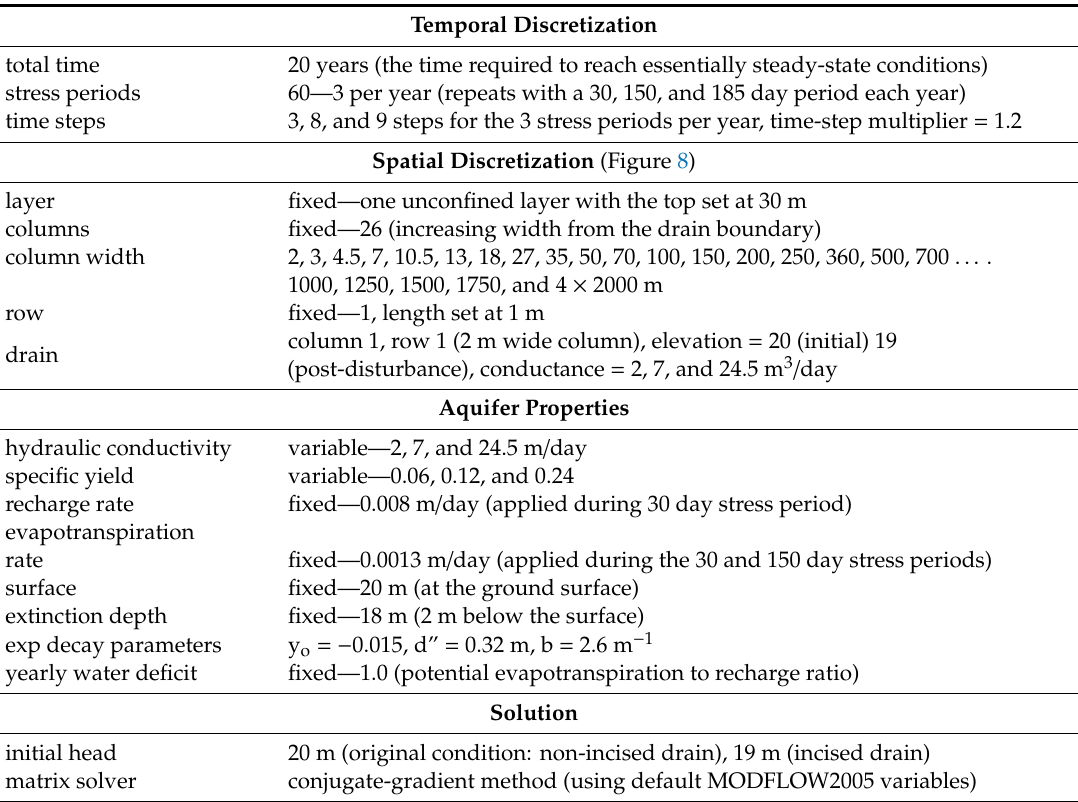
Table 1. Temporal and spatial discretization, aquifer properties, and solution conditions used in the MODFLOW